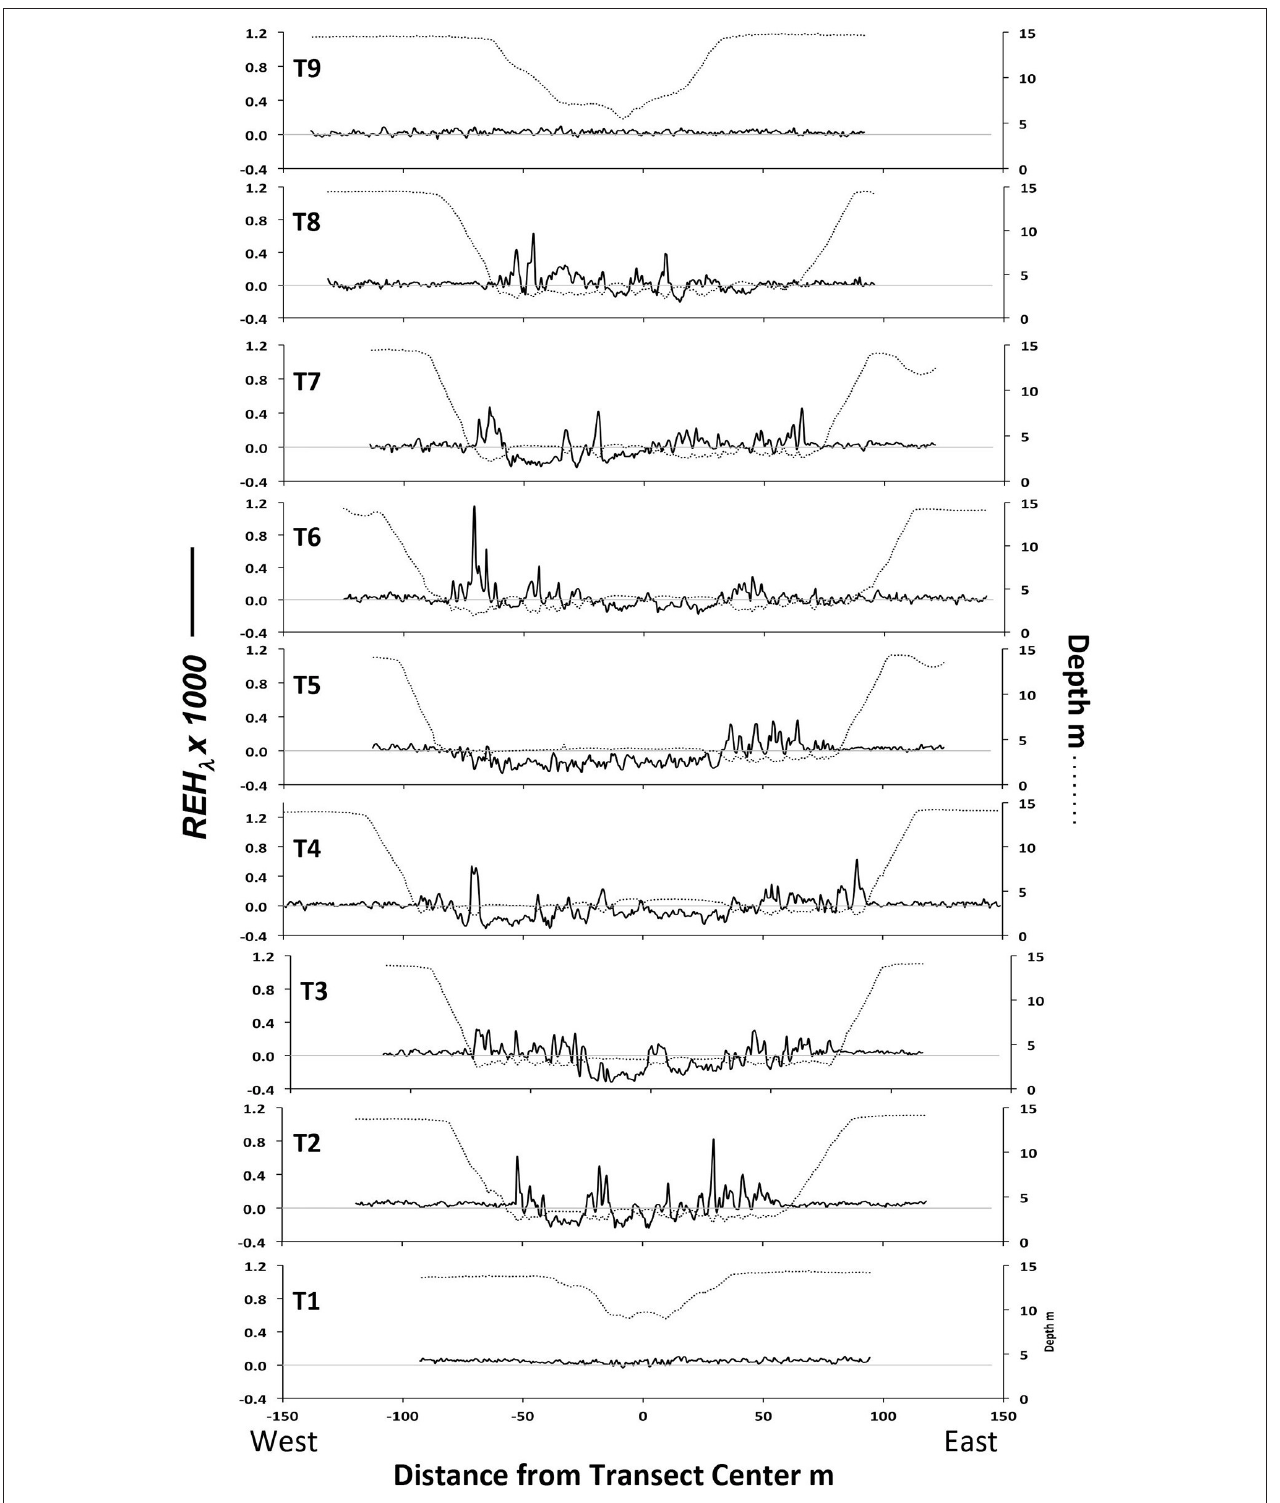
FIGURE 14 | Red edge height ( REH λ , solid curves) and depth (dotted curves) representing observations collected by the ASV along transects across the coconut patch reef.